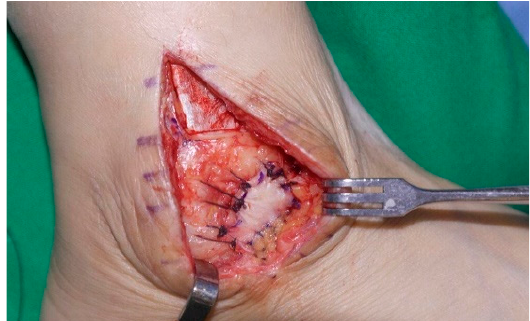
Figure 5. Joint capsule repaired and reinforced using a fibular periosteal flap.